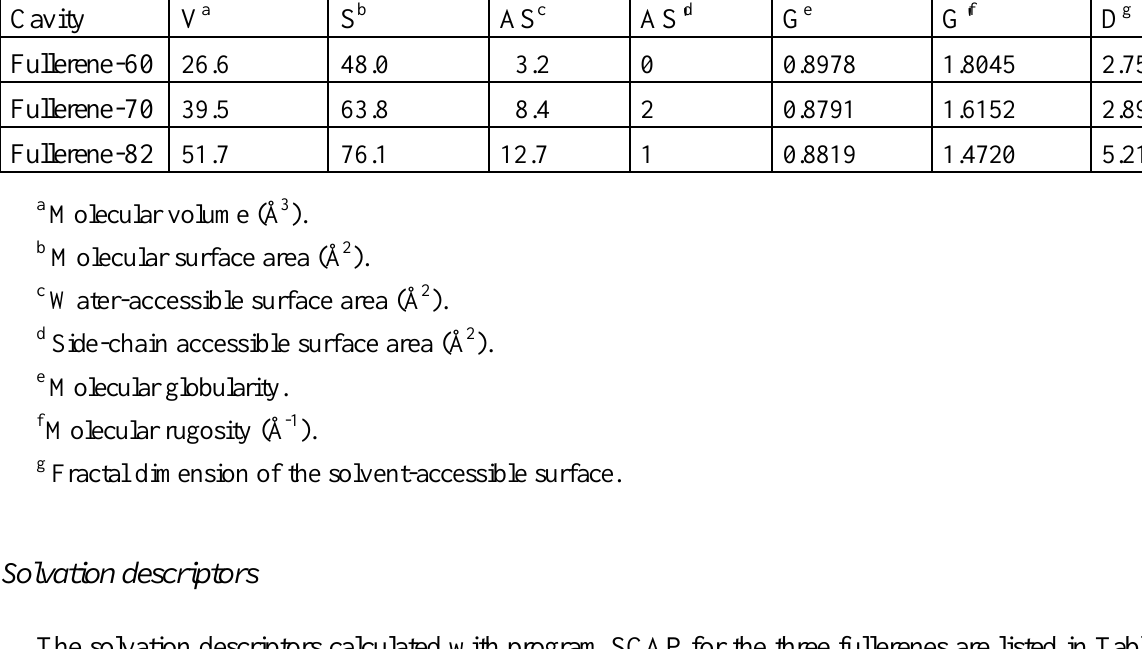
Table 4 . Geometric descriptors and topological indices for the cavities of fullerene-60, -70 and –82. Cavity